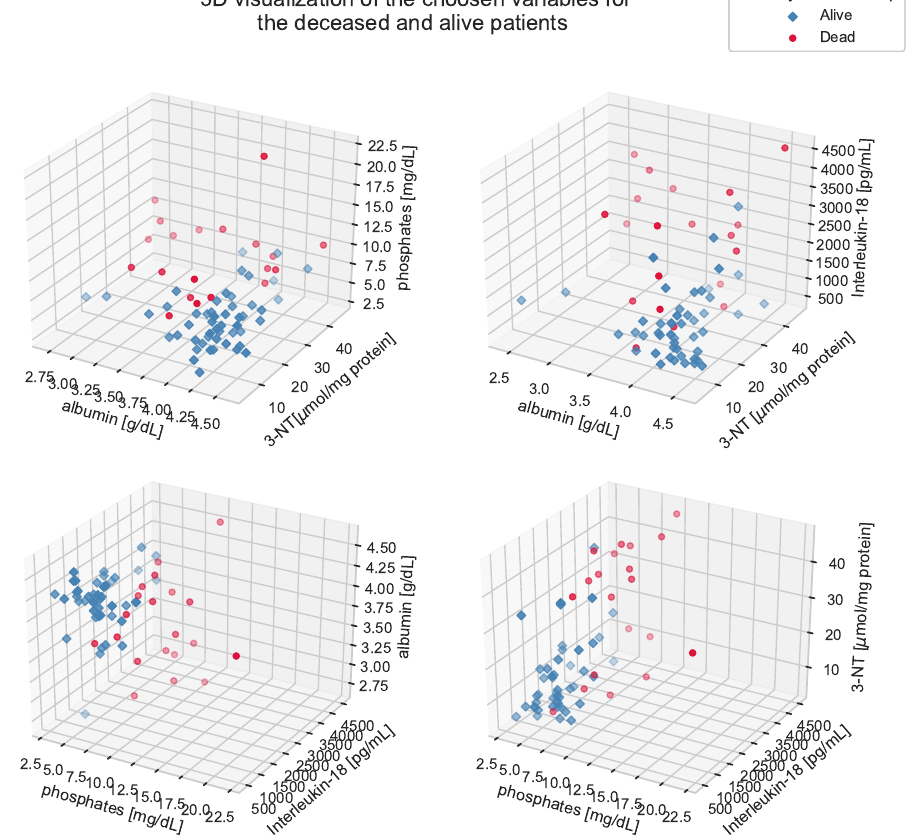
Figure 6. Three-dimensional visualization of spacious relationships between the predictor variables. The HD-A and HD-D groups are marked with blue and red colors, respectively. For the sole purpose of creating a better perception of distances between positions, a color transparency gradient, which highlights depth of the images, has been